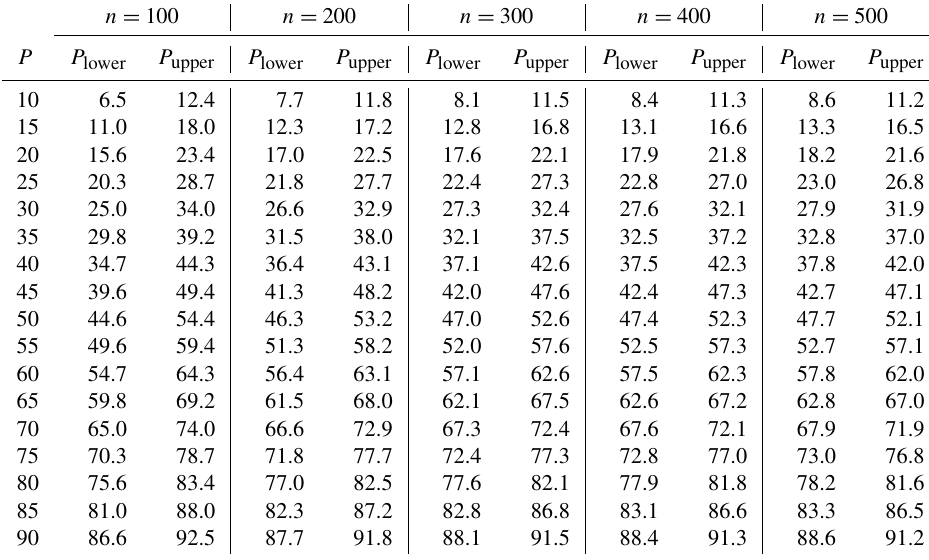
Table B4. Upper and lower percentile confidence interval bounds for α = 0 . 33 (67% confidence